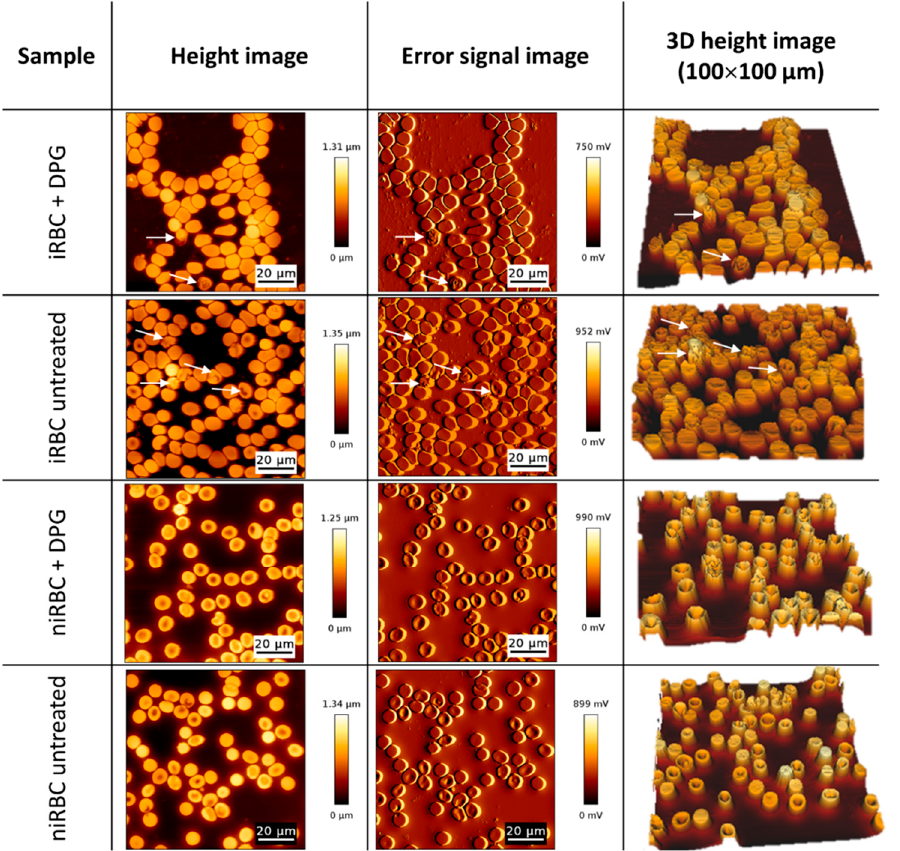
Figure 3. Atomic force microscopy images of cultures with infected RBCs (iRBC + DPG; iRBC untreated) and noninfected RBCs (niRBC + DPG; niRBC untreated) treated with 2,3-DPG and untreated, respectively. Height, error signal and “3D” images (100 µm × 100 µm). White arrows indicate trophozoite-infected RBCs.